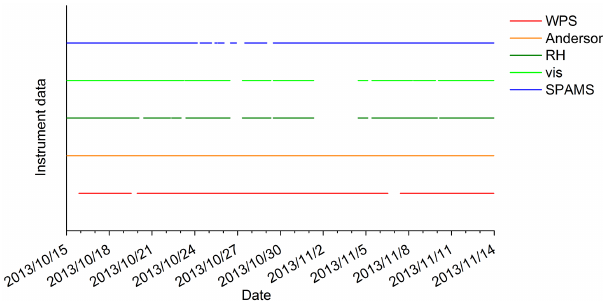
Figure 1. Data coverage during the observation